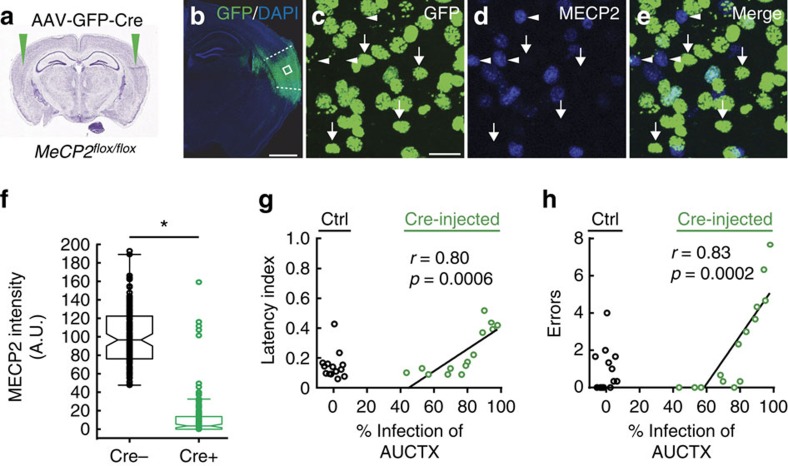
MECP2 expression in the auditory cortex is required for efficient pup retrieval.(a) Diagram depicting AAV-GFP-Cre injection into the auditory cortex (green arrows) of female Mecp2flox/flox mouse. These mice also carried a nuclear localized and Cre-dependent GFP allele (H2B-GFP) that allowed us to directly visualize Cre-positive cells. (b) Photomicrograph of a brain section from a Mecp2flox/flox mouse with AAV-GFP-Cre injection and counterstained with the nuclear marker, DAPI. Dotted lines mark the boundary of auditory cortex. Scale bar=1 mm. (c–e), Magnified confocal images of a selected region boxed in B. GFP+ cells (c, green) are negative for MECP2, as confirmed by anti-MECP2 immunostaining (d and e, blue) (91.2±0.03%; n=685 GFP+ cells, 12 images, 3 mice). Arrows point to GFP+ cells that are MECP2−. Arrowheads point to GFP− cells that are MECP2+, which served as a positive control for MECP2 staining. Scale bar, 20 μm, applies to c–e. (f) Mean MECP2 expression (intensity; A.U.=arbitrary units) in AAV-GFP-Cre infected cells (GFP+) and uninfected cells (GFP−) in the same AAV-GFP-Cre injected animals (n=119 cells per cell type, 3 mice; Mann–Whitney, *P<0.05). Cre-infected cells showed significantly reduced MECP2 expression compared with uninfected cells. Boxplot with standard Matlab-generated whiskers are shown. Notches represent 95% confidence interval of median. Each dot overlaid on the boxplot represents a cell. (g,h) Correlation analysis showed a significant positive relationship between the proportion of auditory cortex expressing GFP-Cre and both gathering latency (g) and number of errors (h) (green dots; N=14 mice; Pearson's r: For G: r=0.80, P=0.0006; for H: r=0.83, P=0.0002). Control Mecp2flox/flox mice injected with AAV-GFP alone (ctrl; black dots) showed normal behaviour (N=14 mice).